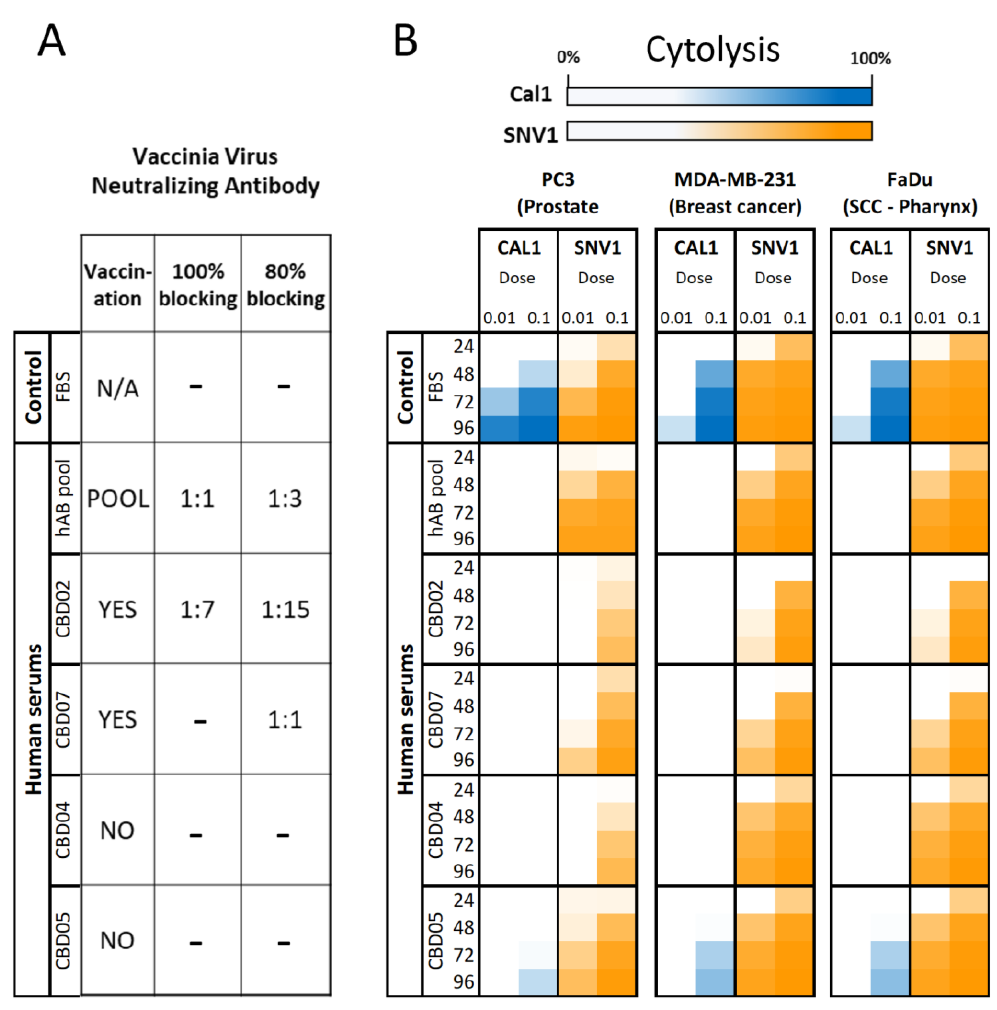
Figure 2. SNV1 Treatment Overcomes Human Serum Induced CAL1 Virus Inactivation. ( A ) Sera from different donors were explored for levels of neutralizing antibodies to CAL1 infectivity blockage before infection on monolayer CV1 cells. Percentage of oncolysis was real time measured using RTCA. Complete (100%) or partial (80%) blockage of the viral infectivity was analyzed. Number indicates serum dilution factors, ( − ) means no dilution, N/A = do not apply. POOL = Serotype AB pool. ( B ) Heatmap shows time courses in which cancer cells were killed by CAL1 and SNV1 at 24, 48, 72 and 96 h post infection in presence of 20% of human serum from AB pool or different donors with or without existing vaccinia virus neutralizing antibodies. CBD02, CBD07, CBD04, CBD05 are the individual human serum donors. Cytolysis was automatically analyzed by measuring cell impedance every 15 min using the RTCA MP Instrument. Results are the average of 4 replicate wells. RTCA = Real-time cell analysis; SNV1 = Supernova-1; SCC = squamous cell carcinoma. MOI for SNV1 is calculated by considering one stem cell loaded with CAL1 viruses (SNV1) as 1 infection unit, as cells are added as infection units and not free viruses to treat cells in culture. The SNV1 lot was released by quantifying the viral load per cell by